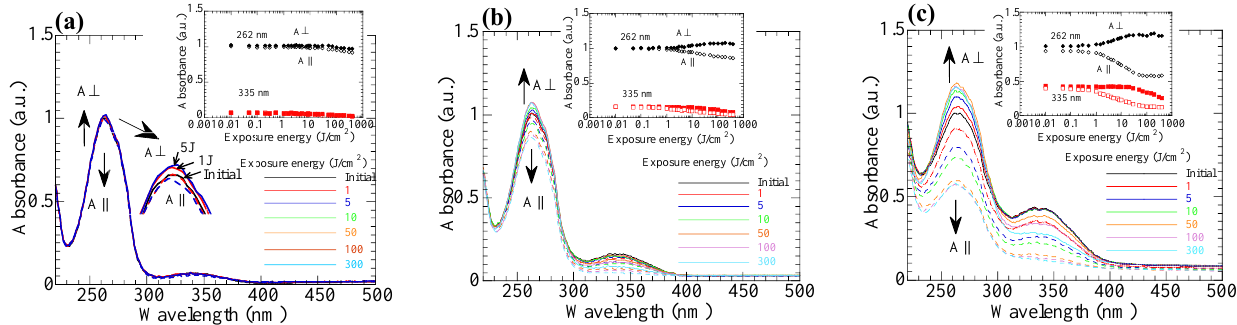
Figure 3. Changes in the polarized absorption spectra of the PNx films upon exposure to LP 365-nm light. Insets plot the absorbances at 262 and 335 nm. ( a ) PN10 , ( b ) PN20 , and ( c ) PN50 .